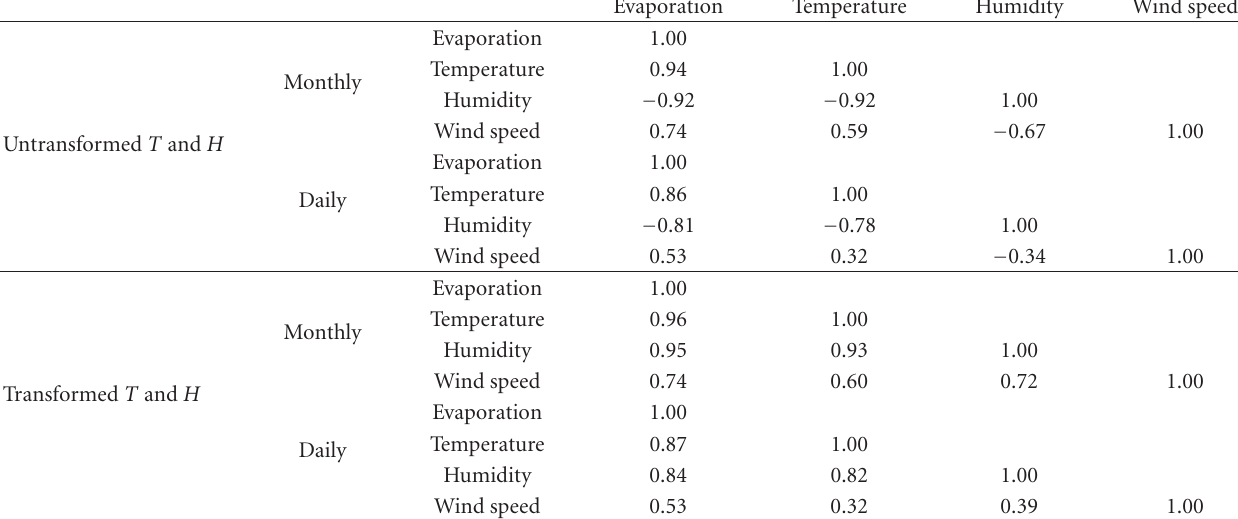
Table 2: Correlation coe ffi cients of daily and monthly average meteorological data for Kuwait from 1993 to